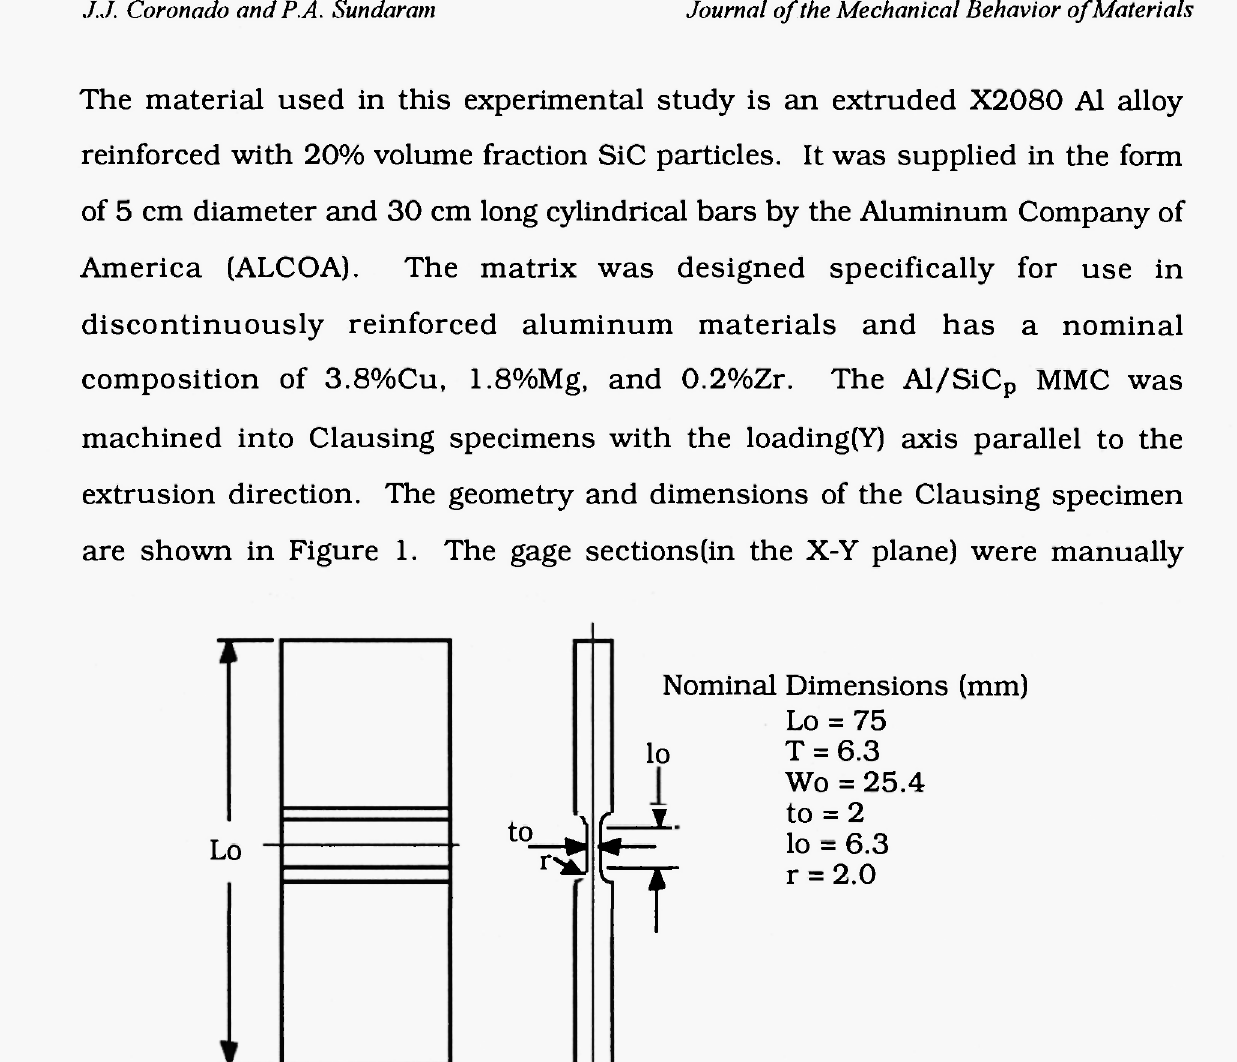
Fig. 1. Geometry and dimensions of Clausing type plane stress/plane strain tensile